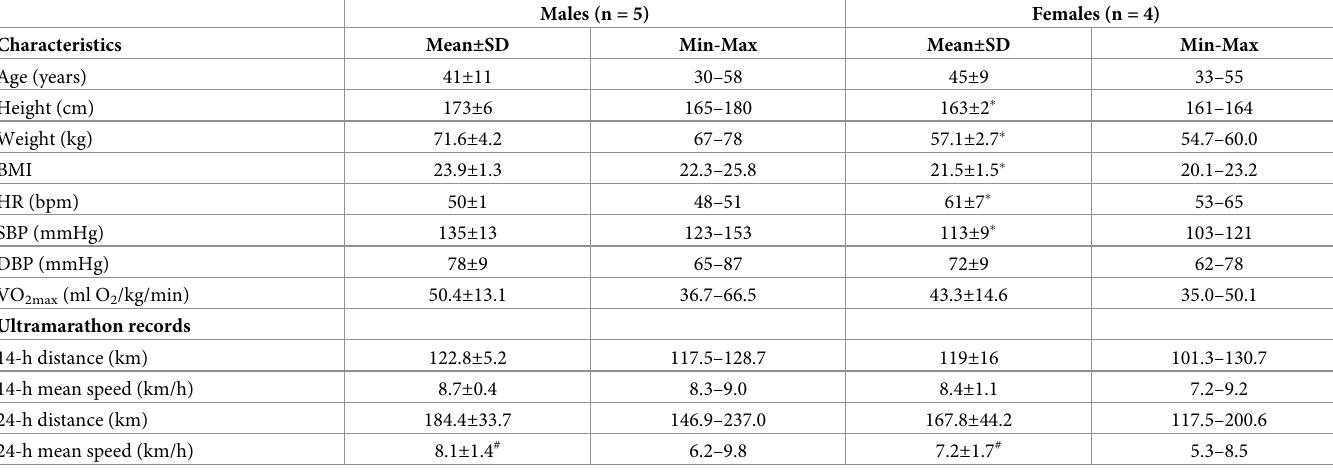
Table 1. Baseline characteristics and ultramarathon records of the runners which completed the race (n =